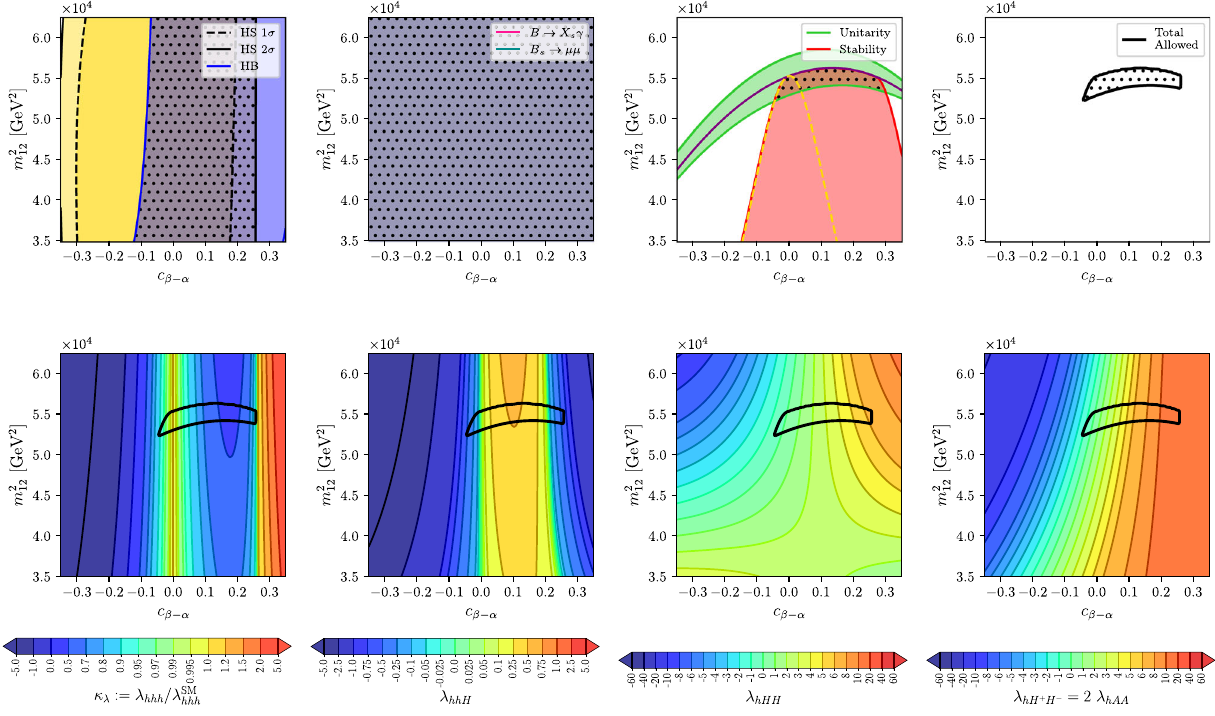
Fig. 5 Allowed areas (dotted regions) from the various constraints (upper row) and triple Higgs couplings (lower row) for the benchmark scenario I-2 in the c β − α – m 2 plane with tan β = 7 . 5 and m = 650 12